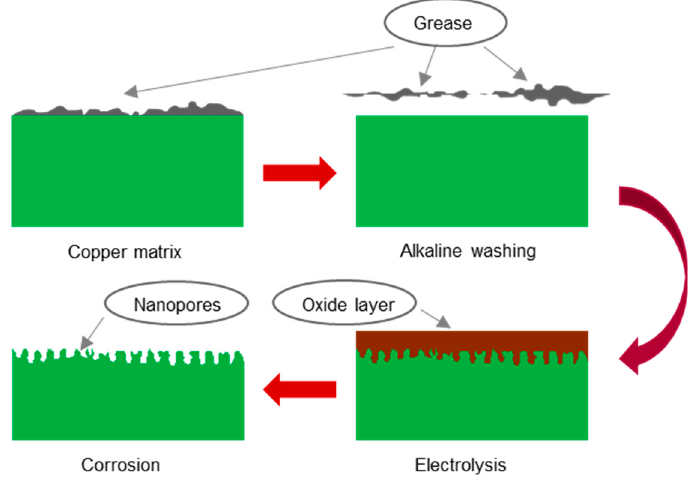
Figure 1. Schematic representation of surface treatment procedure for copper. (a) Pretreatment: Before anodic oxidation, the copper surface needed to be cleaned to remove oil stains, rust stains, and dust. First, the copper was rinsed with tap water to remove dust. Second, the copper was rinsed with alcohol and acetone for 5 min to remove oil stains. Third, the copper was rinsed with a 1% sodium hydroxide solution for 3